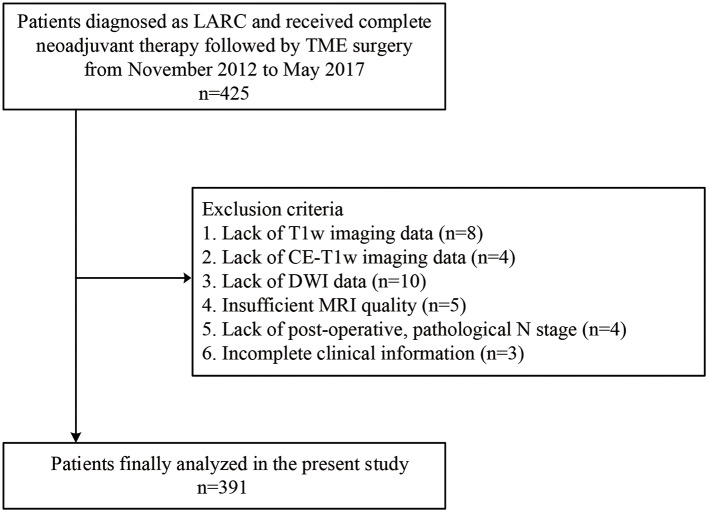
Recruitment pathway for patients in this study. LARC, locally advanced rectal cancer; T1w, T1-weighted; CE-T1w, contrast-enhanced T1-weighted; DWI, diffusion-weighted imaging; MRI, magnetic resonance imaging.